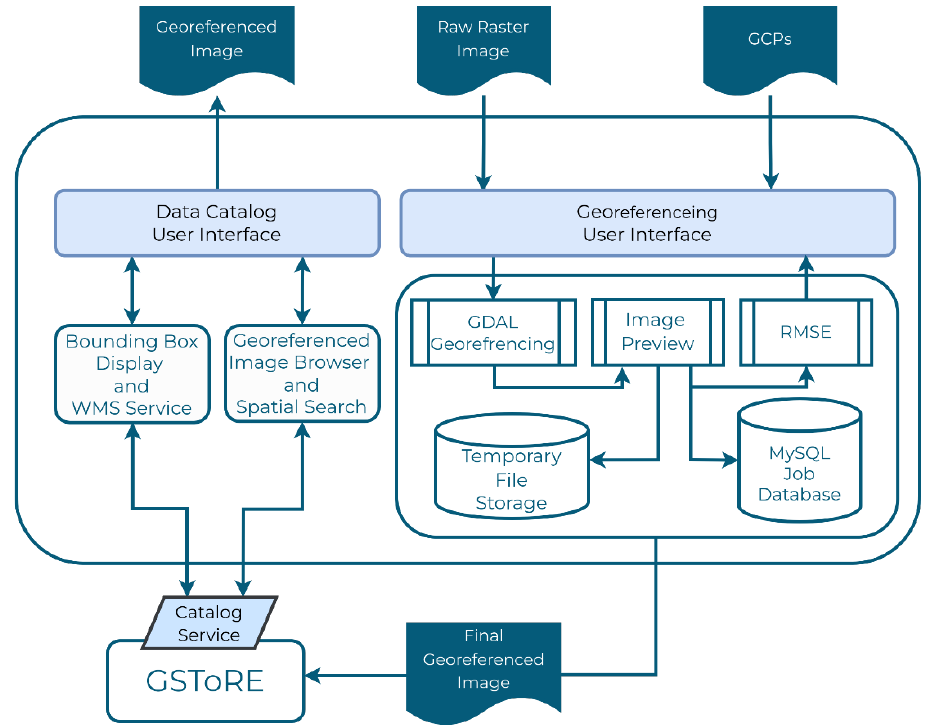
Figure 2. The architecture of the developed georeferencing web application. GCPs denote ground control points, GDAL denotes Geospatial Data Abstraction Library, RMSE denotes root-mean-squared error, and GSToRE denotes Geographic Storage, Transformation, and Retrieval Engine.